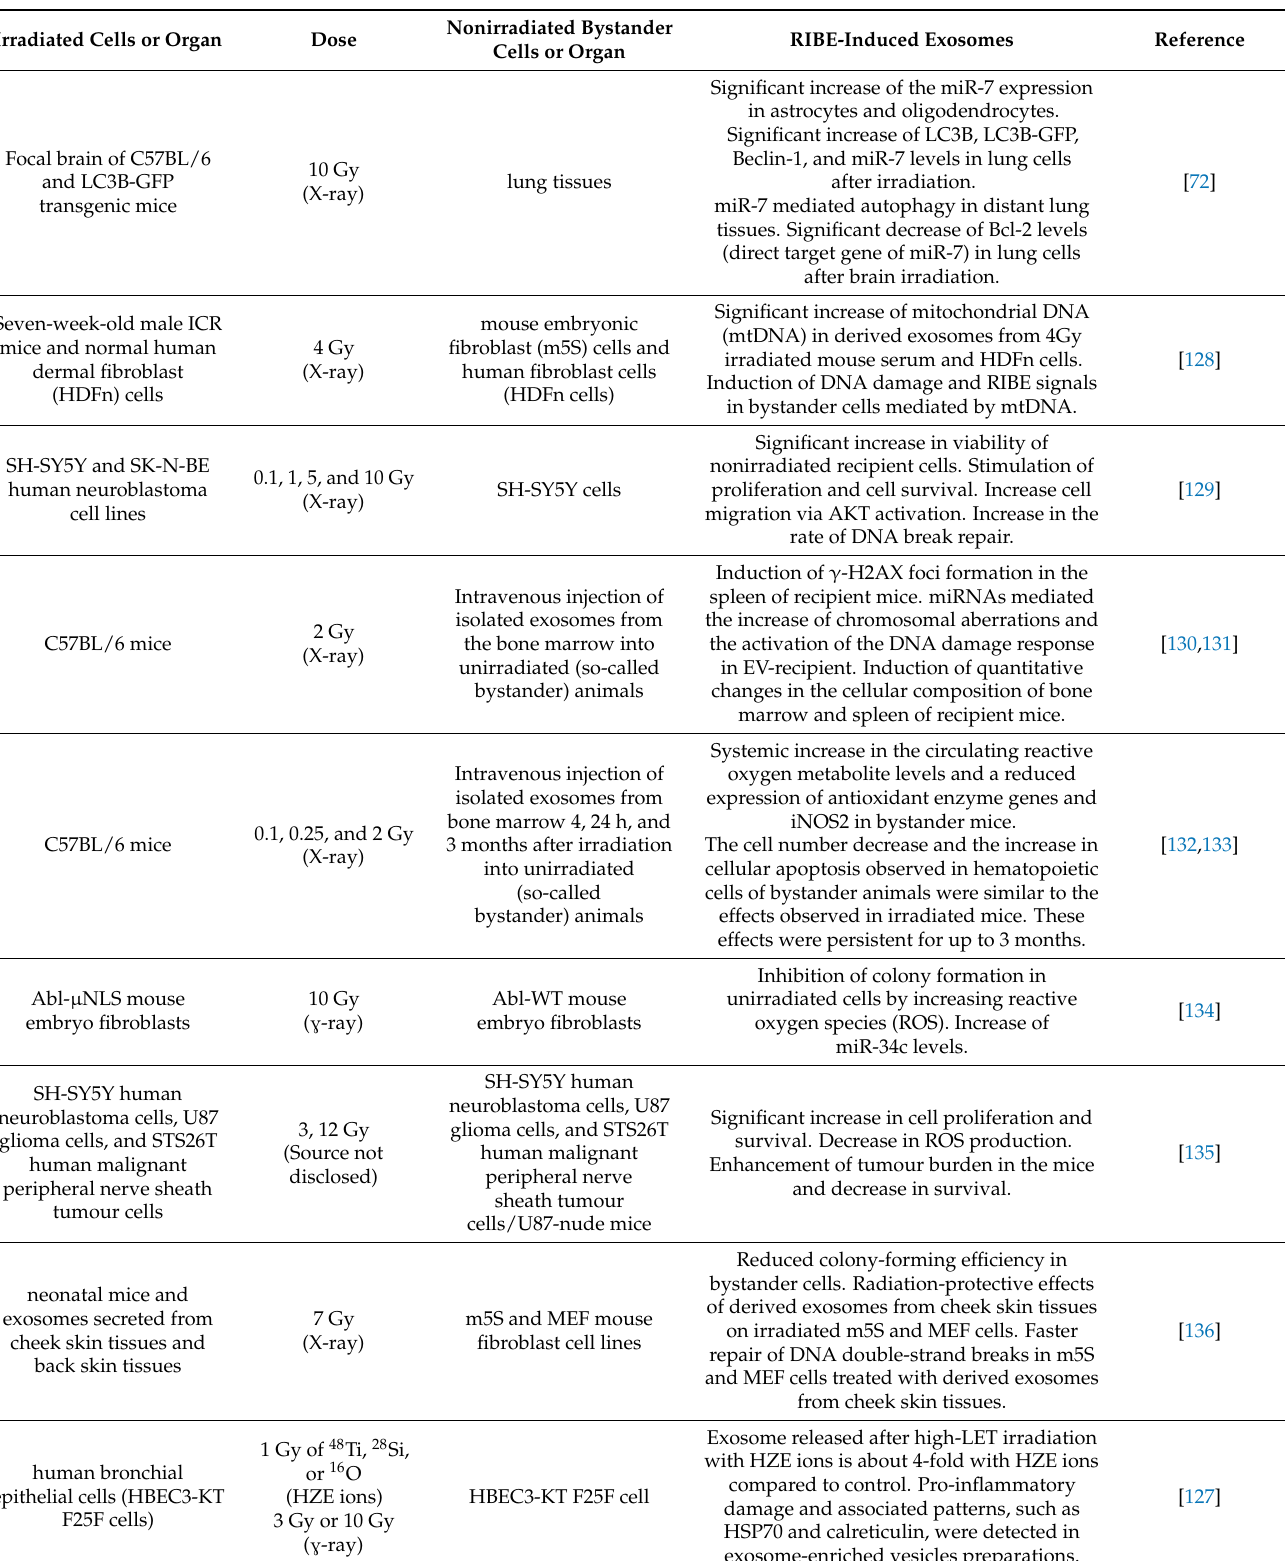
Table 2. RIBE effects mediated by exosomes released by various irradiated or nonirradiated bystander cells or